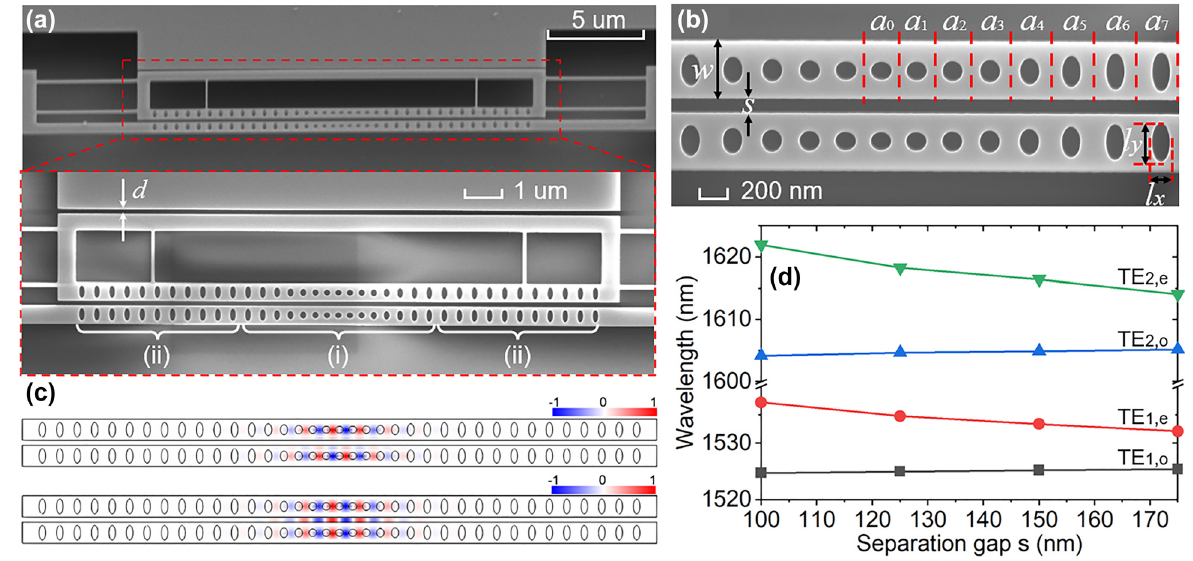
Figure 2: Optomechanical zipper cavity.